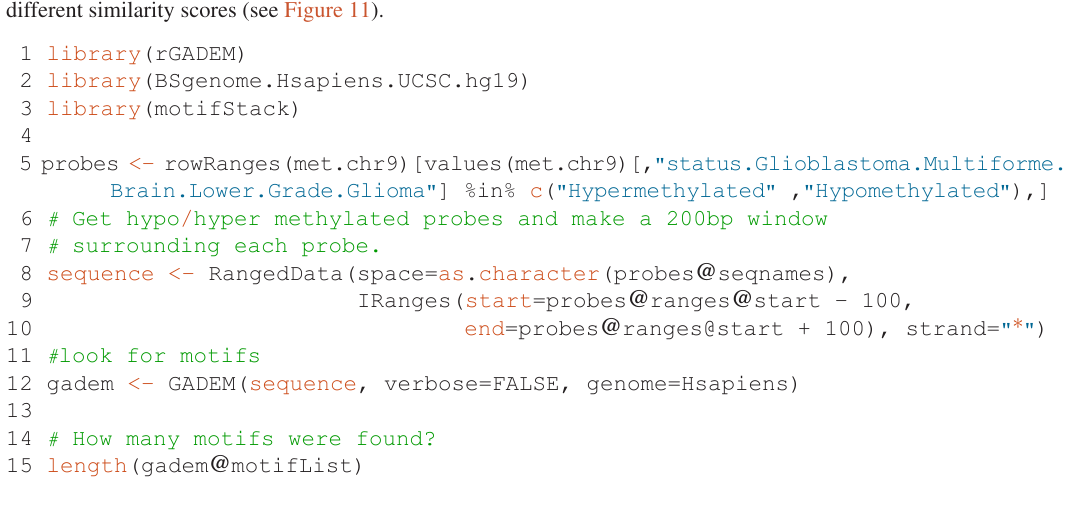
in the Listing 21). An object will be returned which contains all relevant information about your motif analysis (i.e., sequence consensus, pwm, chromosome, p-value,